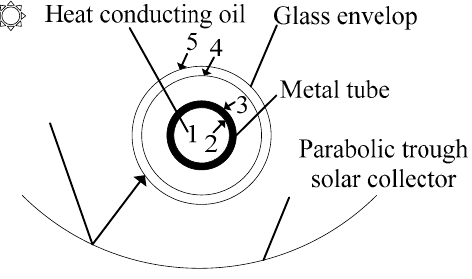
Figure 2. PTC structure diagram.